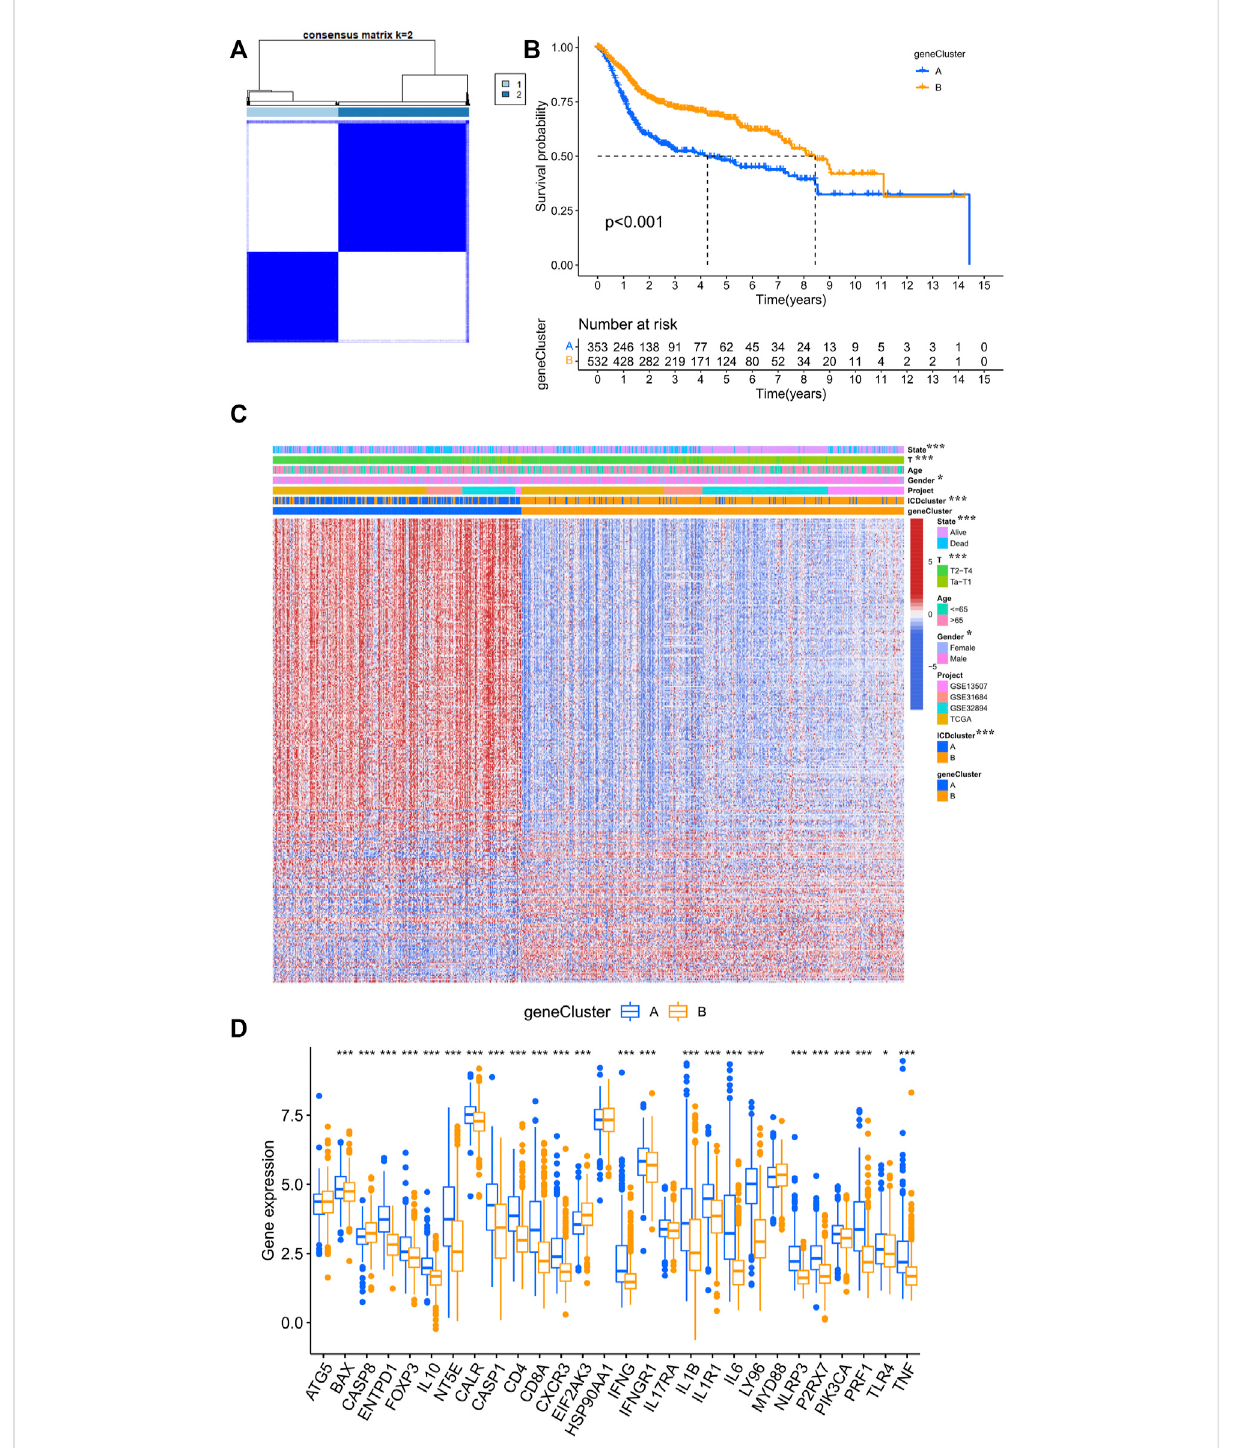
FIGURE 4 ICD gene clusters in the merged cohort. (A) Consensus clustering matrix for k = 2. (B) Kaplan – Meier curve survival analysis among two distinct gene clusters. (C) Heatmap demonstrating various clinicopathological features of two distinct gene clusters. (D) Different expression levels of 28 IRGs in distinct gene clusters. The asterisk symbol indicated the statistical p -value. (* p < 0.05; ** p < 0.01; *** p <